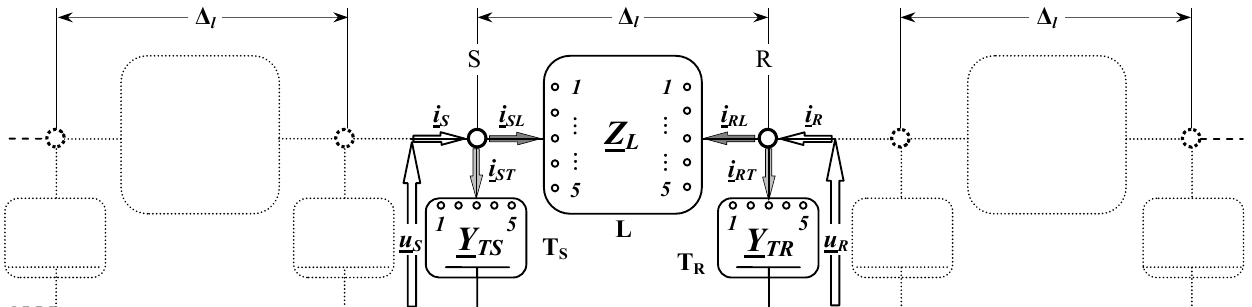
Figure 2. Cascade of N elementary cells for OHL